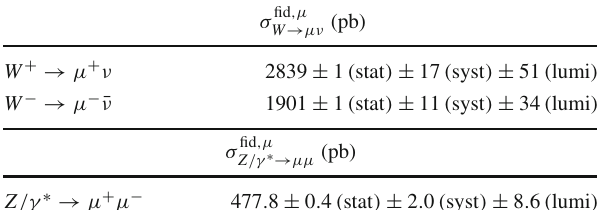
Table 5 Fiducial cross sections times branching ratios for W + , W − , and Z /γ ∗ (66 < m μμ < 116 GeV) production in the muon decay channel.Thefiducialregionsusedforthemeasurementarethosedefined for the combined fiducial regions in Sect. 2.3, except that the muon pseudorapidity is restricted to be within | η | < 2 . 4. The uncertainties denote the statistical (stat), the systematic (syst), and the luminosity (lumi) uncertainties